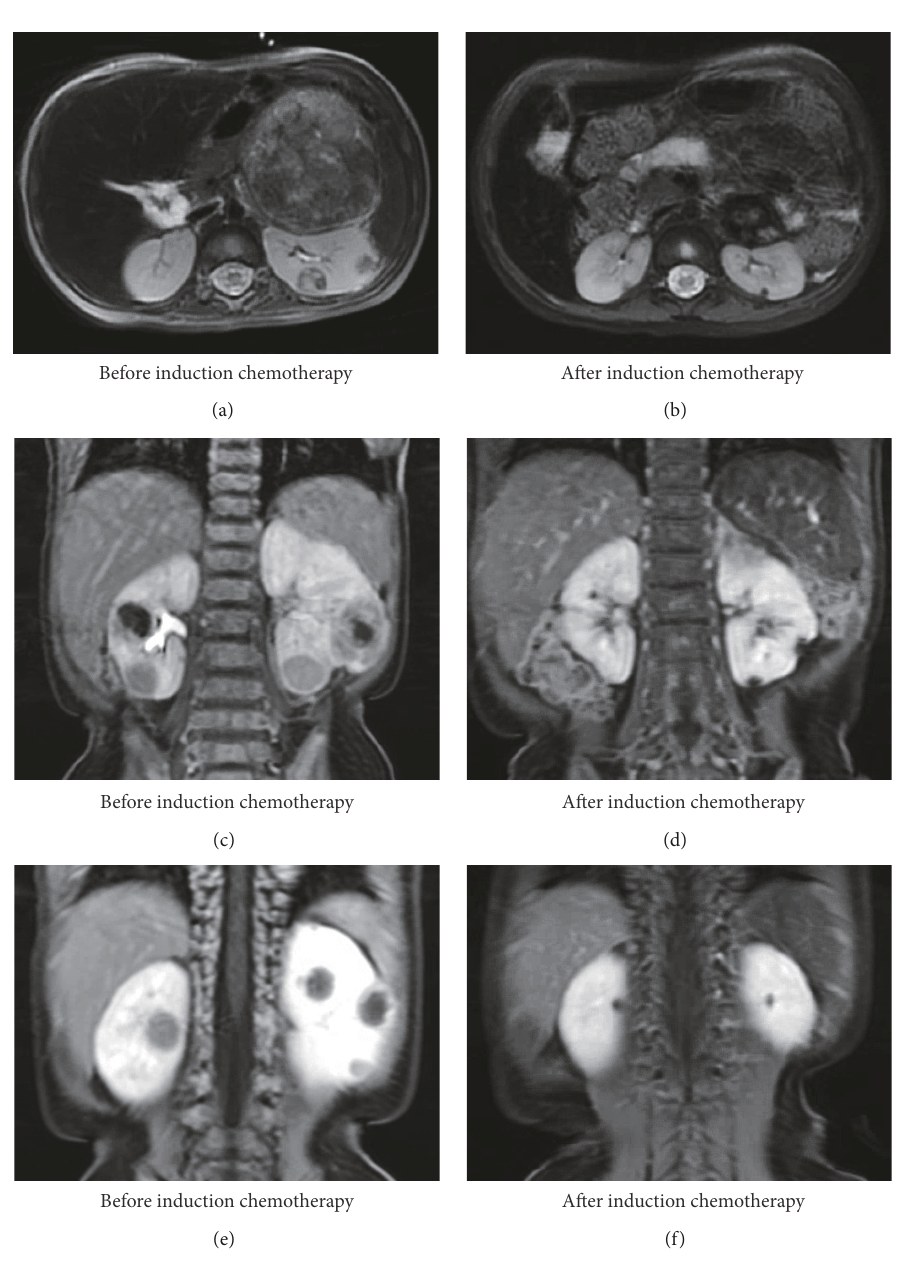
Figure 1: MRI findings before and after induction chemotherapy. Before induction chemotherapy, the T2-weighted axial image (a) and contrast enhanced coronal images (c, e) revealed a left adrenal mass and multiple bilateral renal masses. After induction chemotherapy, the T2-weighted axial image (b) and contrast enhanced coronal images (d, f) showed that the primary tumor and all lesions in bilateral kidneys had decreased in